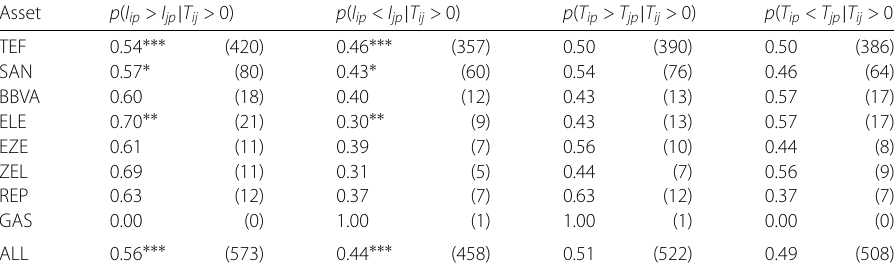
Table 4 Influence of individual reaction to price over the Anticipation network. The table is divided in four groups across the 8 different markets plus the aggregation of all them. For all significant links from i to j ( T ij > 0) for each network (market), we computed the probability of i being more synchronized with price than j (first group), i being less synchronized than j (second column), i having a higher value for the STE with respect to price than j (third group) and i having a higher value for the STE with respect to price than j (fourth group). FDR approach described in “Methods” section is used here to discriminate the significant links. Additional file 1 contains an equivalent table using Bonferroni instead of FDR method displaying similar results. Numbers between brackets account for the frequency. Asterisks refer to different confidence interval levels, ∗ for 90%, ∗∗ for 95%, and ∗∗∗